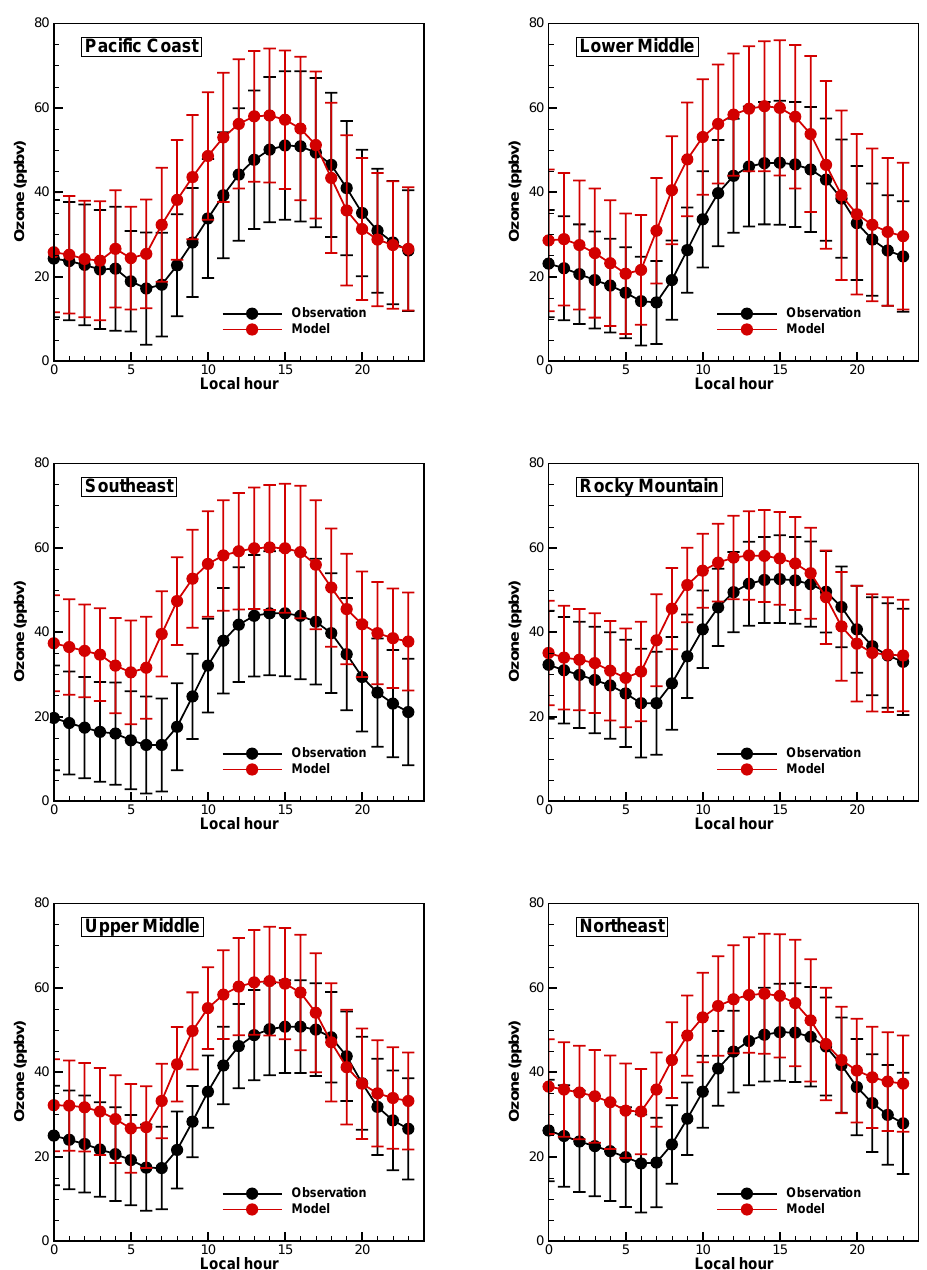
Fig. 11. Diurnal profiles of ozone in August 2010 for each of the six regions listed in Fig. 1. Average concentrations of the AQS observations and their NAQFC counterparts are shown with their standard deviations as a function of local